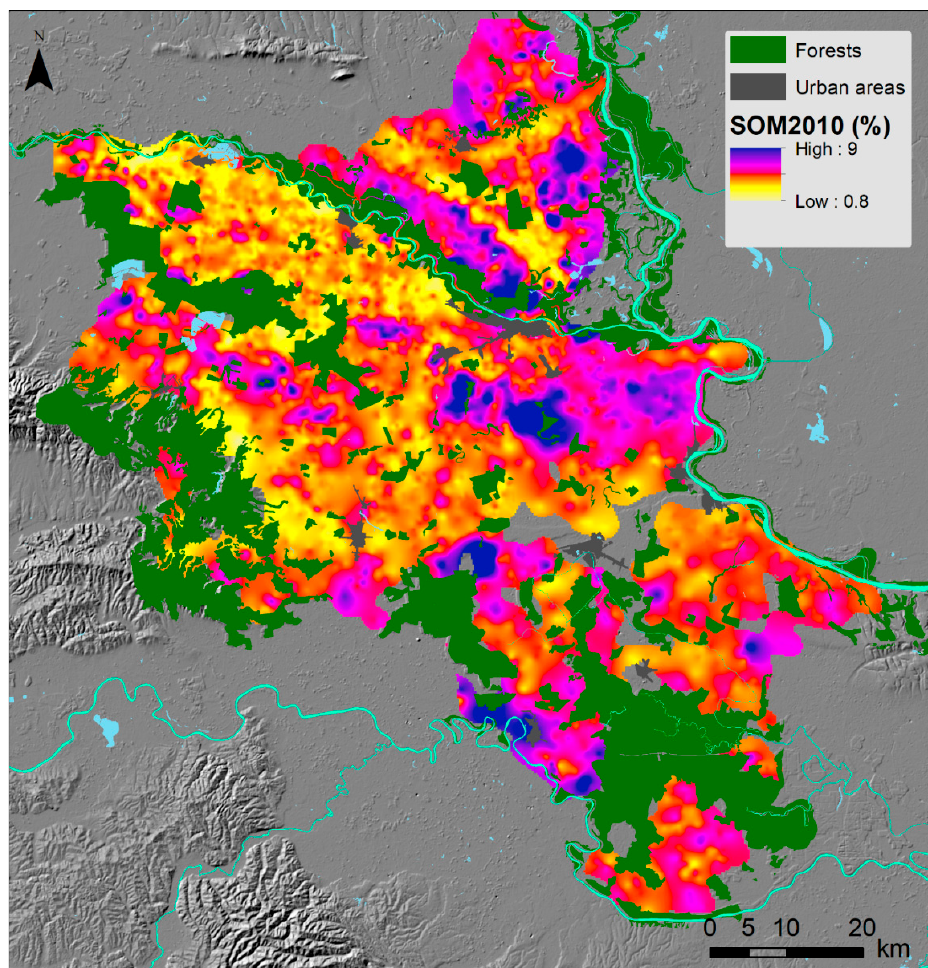
Figure 8. Spatial distribution map of SOM2010 via ordinary block kriging with a spatial support of 250 m (areas with a prediction standard deviation >0.5% have been blanked).